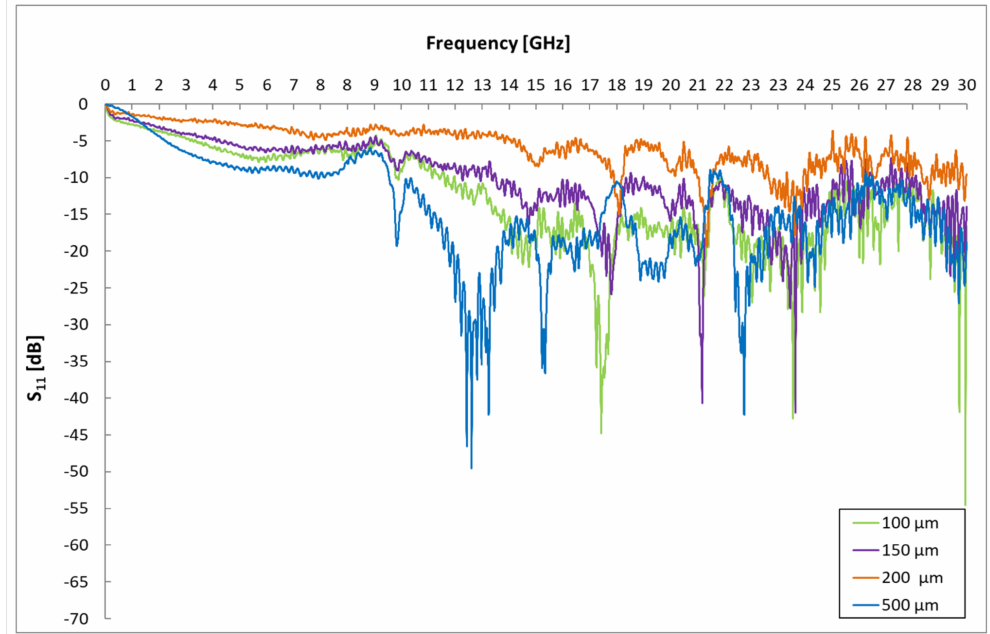
Figure 5. Influence of IDE gap on S 11